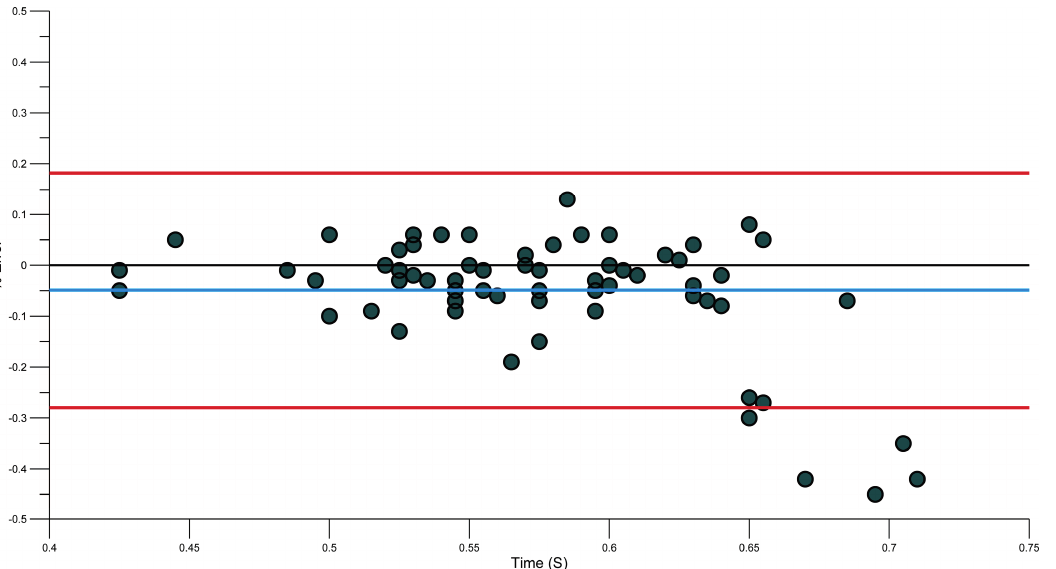
Figure 15. Bland-Altman plot of Recovery Duration